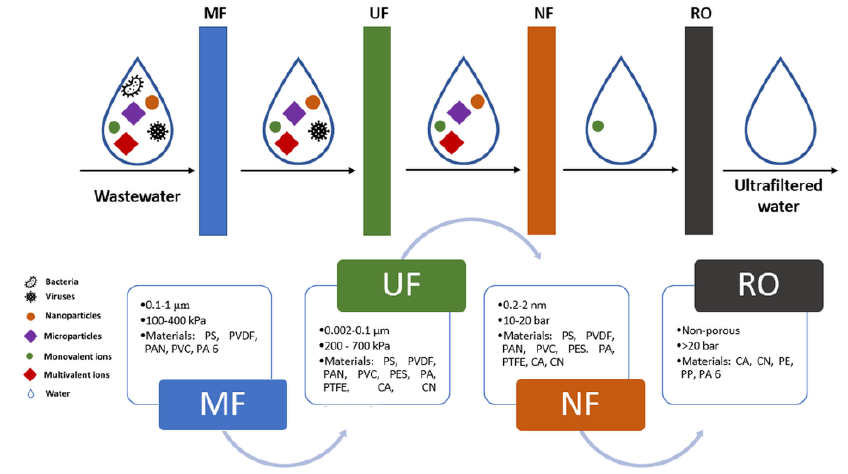
Figure 4. Membrane separation processes and polymers used for this purpose.